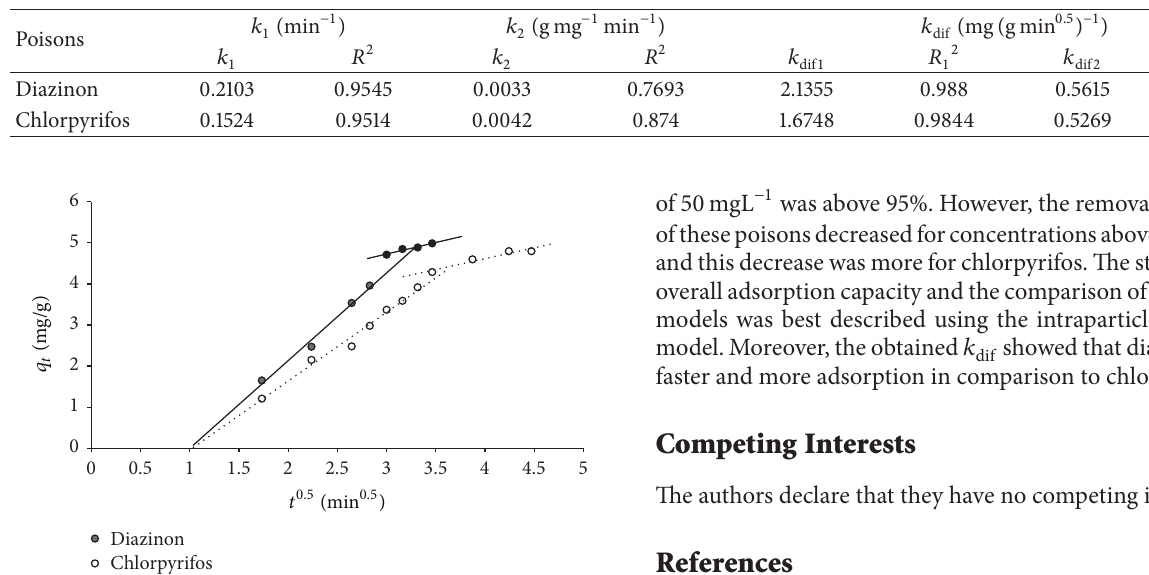
Figure 7: Intraparticle diffusion model for adsorption of diazinon and chlorpyrifos by